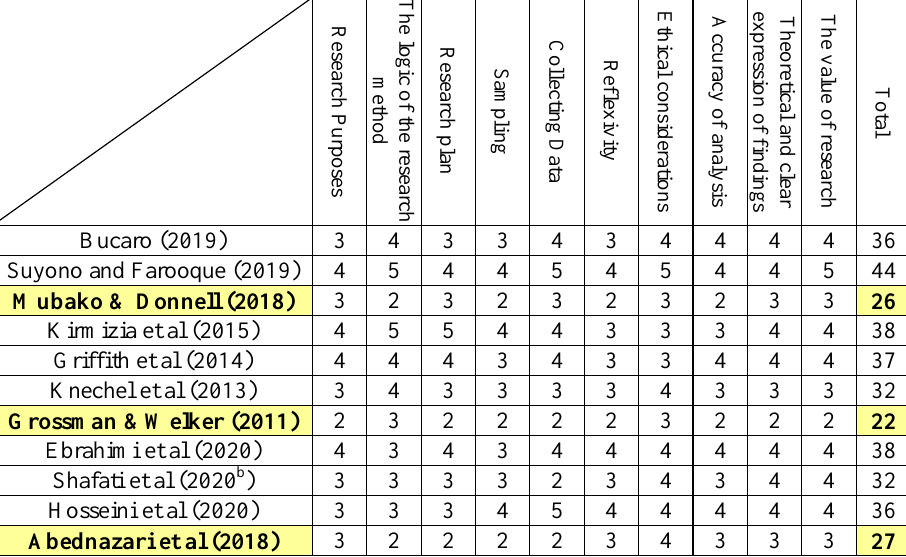
Table 4. the critical analysis process of screened